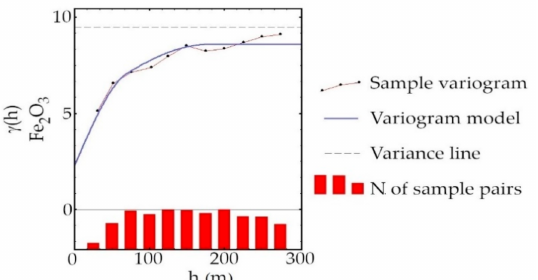
Figure 5. Sample variogram and variogram model for iron concentration obtained by samples Fe 2 O 3 (%). h(m) is the distance and γ (h) is the sample variogram.